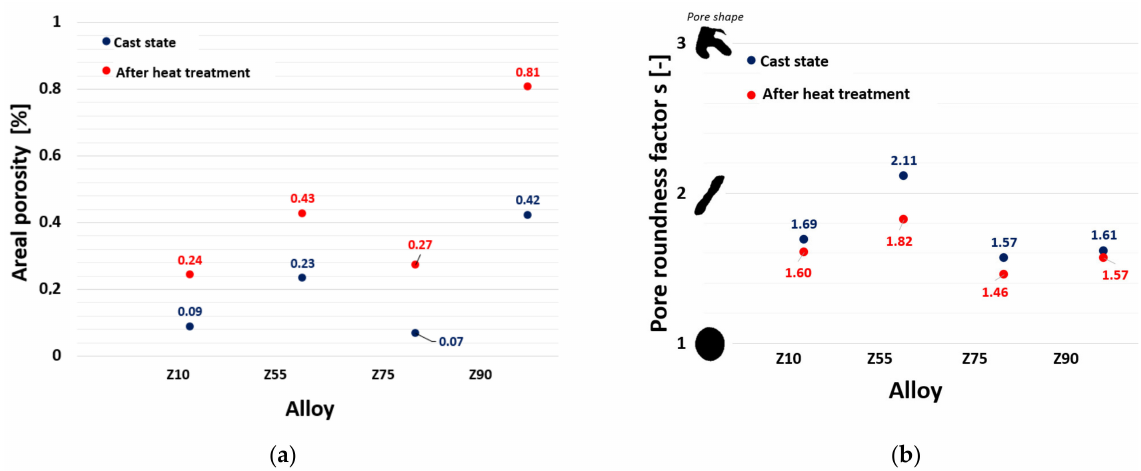
Figure 13. Evaluation of porosity on the A-A cut (incision): ( a ) Areal porosity; ( b ) Pore roundness factor.